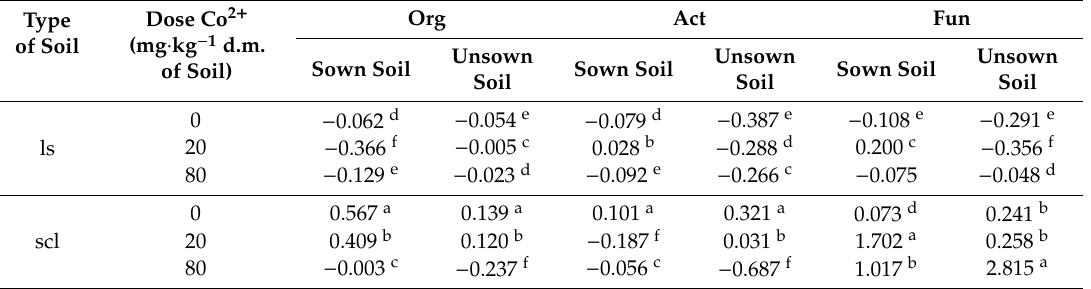
Table 7. Index of zeolite e ff ect ( IF z ) on the microorganism count in soil.